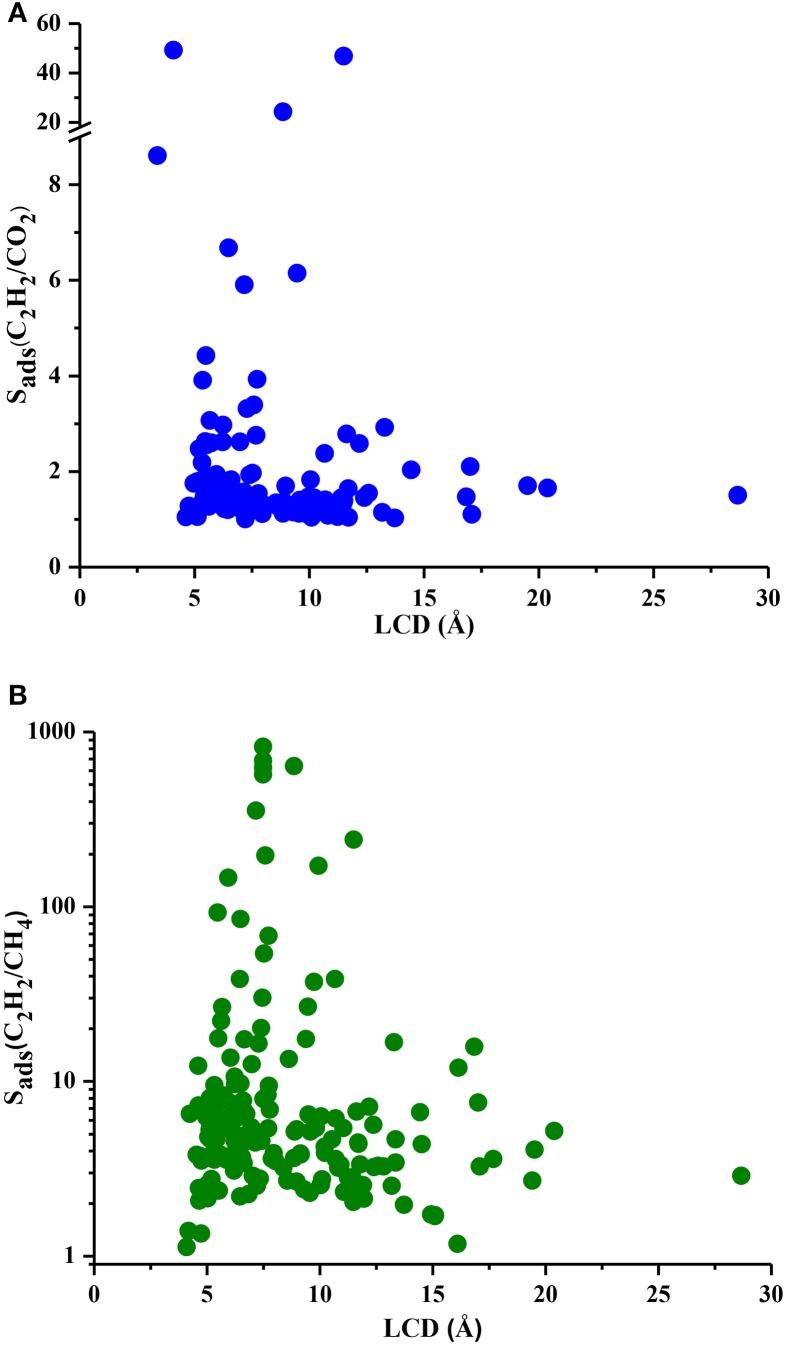
Sads and LCD of MOFs for (A) C2H2/CO2 and (B) C2H2/CH4 mixtures.